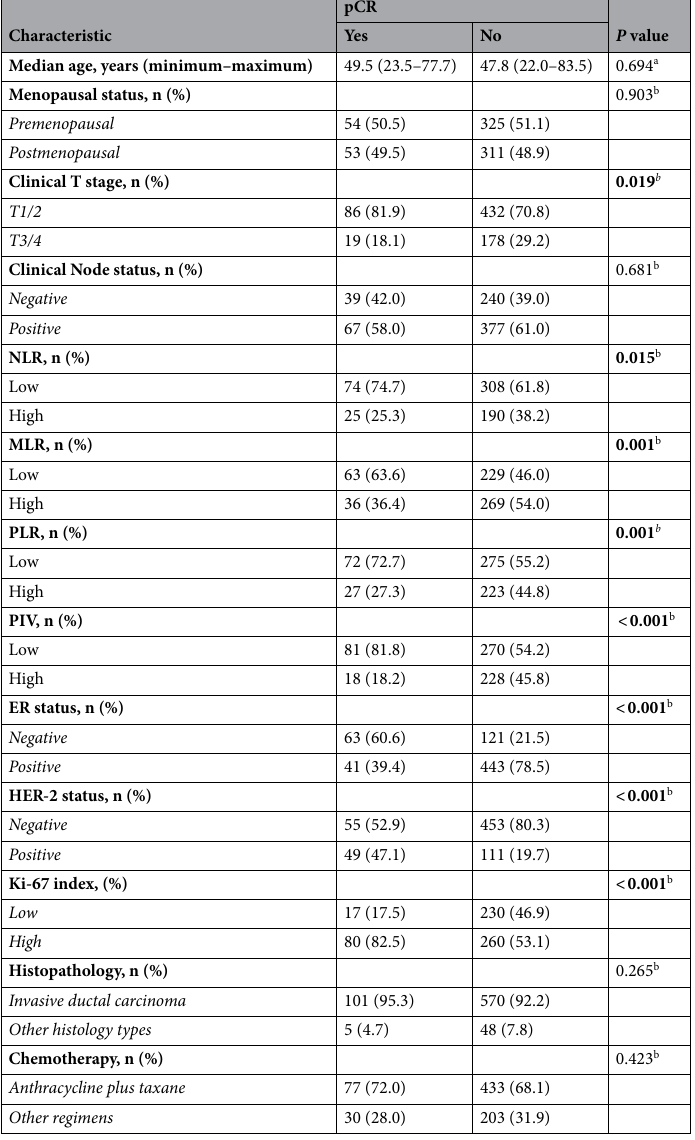
Table 3. Association between the patients’ characteristics and pCR. pCR pathological complete response, NLR neutrophil-to-lymphocyte ratio, MLR monocyte-to-lymphocyte ratio, PLR platelet-to-lymphocyte ratio, PIV Pan-immune-inflammation-value, ER estrogen receptor, HER-2 human epidermal growth factor receptor-2. a Mann-Whitney test; b Pearson’s Chi-squared test. Data are given as counts (percentages) unless otherwise indicated. Bold numbers indicate statistical